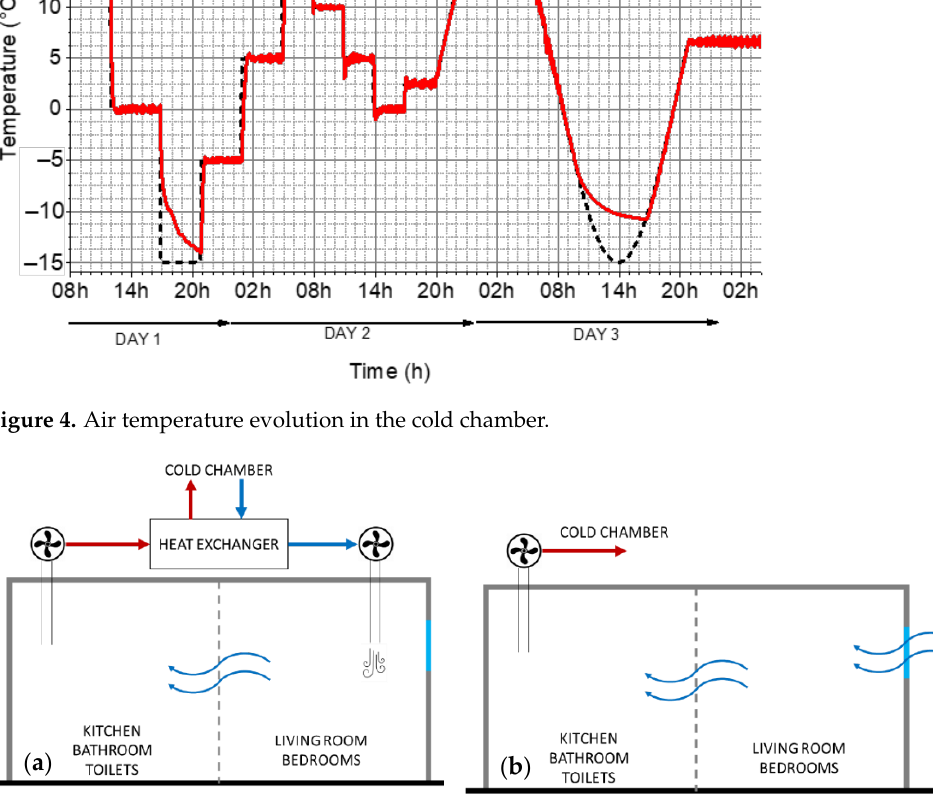
Figure 4. Air temperature evolution in the cold chamber.